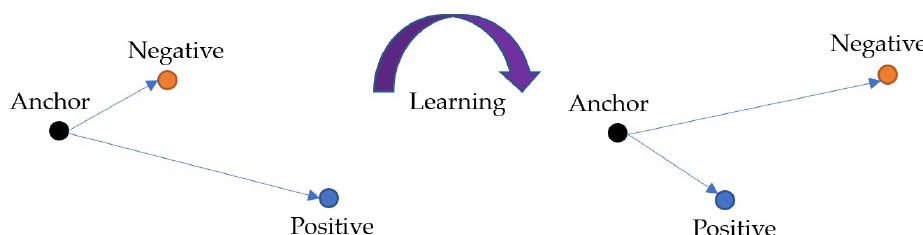
Figure 8. The triplet loss trains a neural network to increase the difference between the embeddings of different classes while minimizing the difference between the embeddings of the same class by selecting an anchor, a positive sample, and a negative